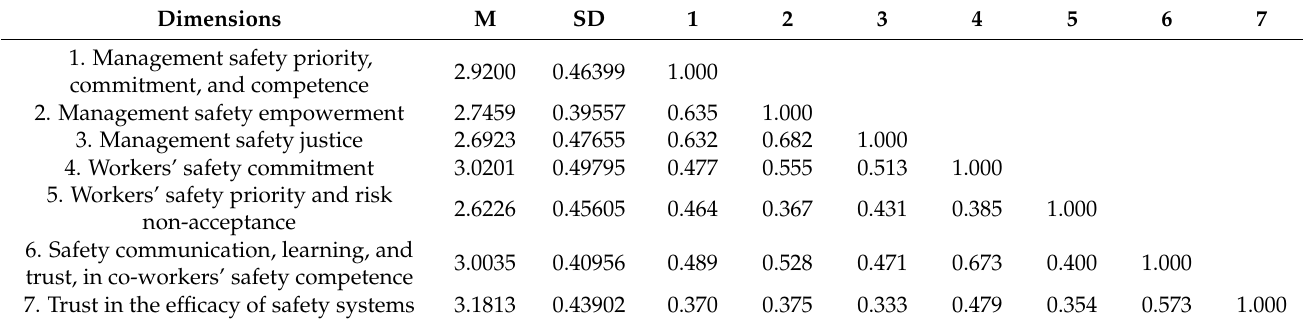
Table 4. Summary of the inter-correlation matrix testing the correlation between the seven safety climate dimensions.